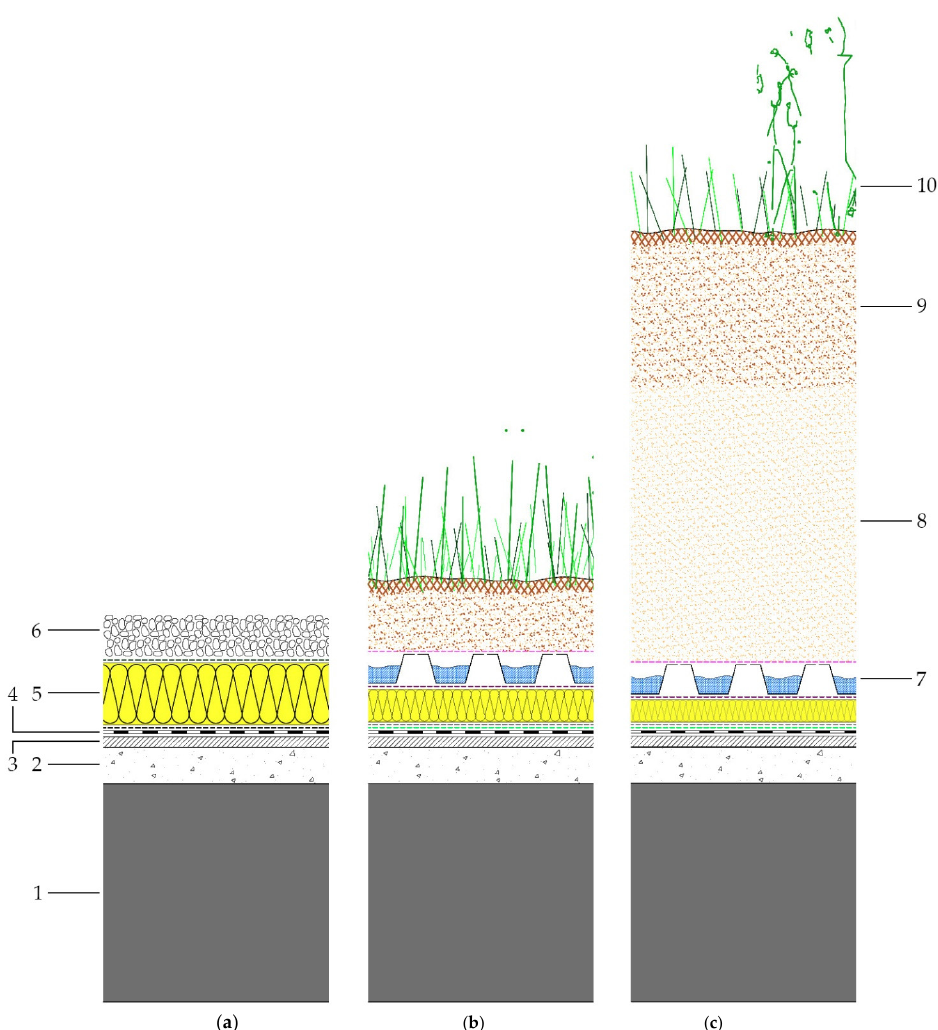
Figure 3. Roof models proposed for refurbishment: ( a ) traditional with gravel finish; ( b ) green extensive; ( c ) green intensive. Legend: (1) Support structure; (2) Slope formation; (3) Regulation mortar; (4) EPDM waterproof sheet; (5) XPS thermal insulator; (6) Gravel; (7) Drainage layer + Filter sheet; (8) Inorganic substrate; (9) Organic substrate; (10) Vegetation.